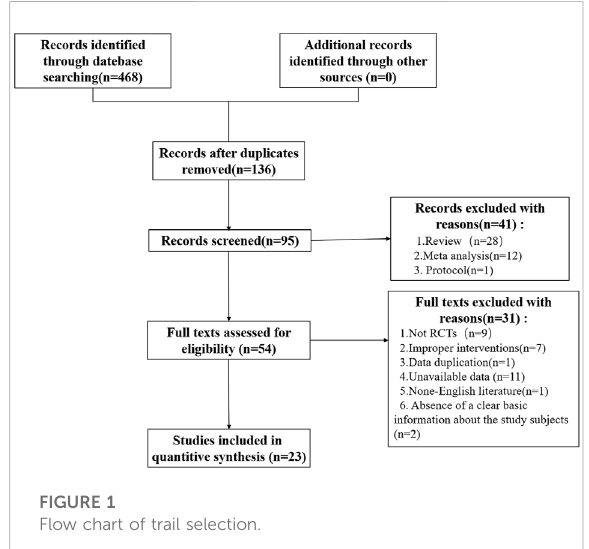
FIGURE 1 Flow chart of trail